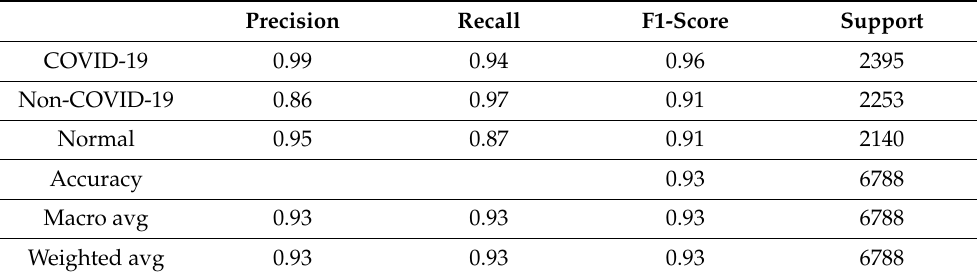
Table 5. DenseNet121 Evaluation results.